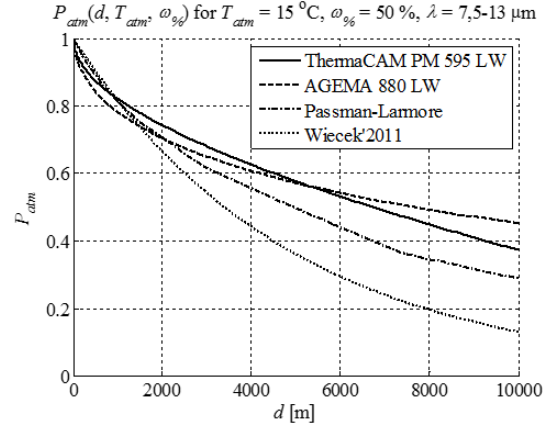
Figure 10. Characteristics of atmospheric transmission coefficient P atm = f ( d ) for a few models described in this paper for a distance up to